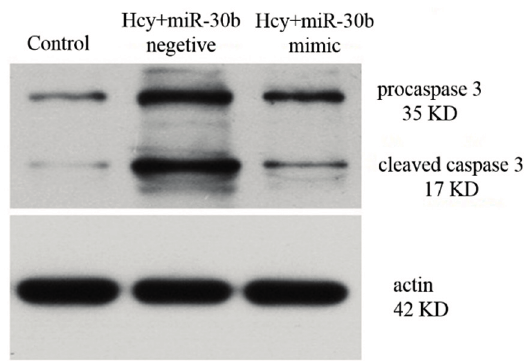
Figure 7. The expression of procaspase-3 and cleaved caspase-3 protein after overexpression of miR-30b in Hcy-induced HCAECs, the concentration of Hcy was 1 mmol/L, both the time of transfection and treatment of Hcy were 24